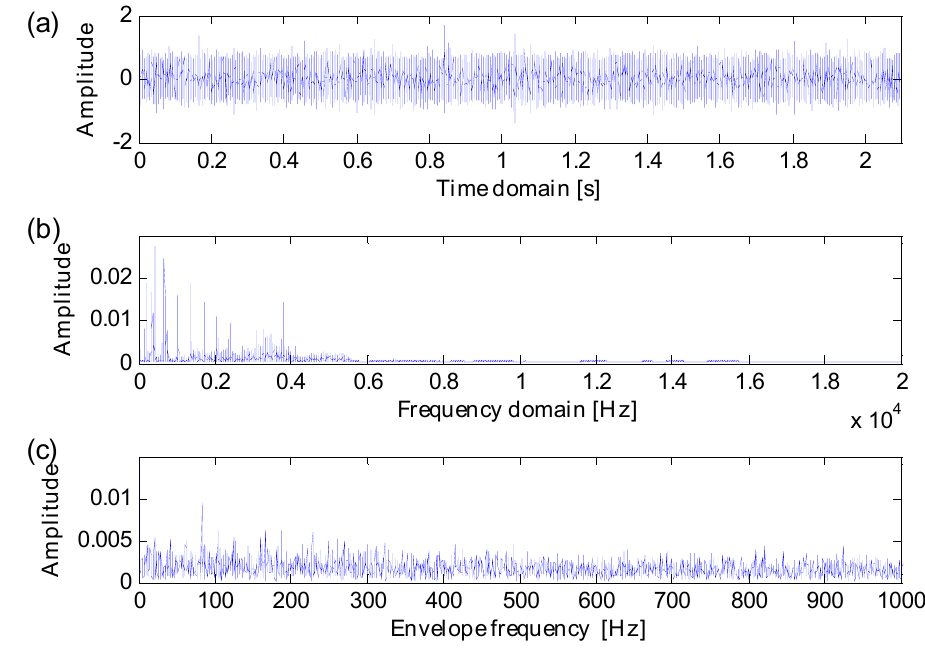
Figure 19. ( a ) Vibration signal; ( b ) frequency spectrum; ( c ) envelope spectrum.